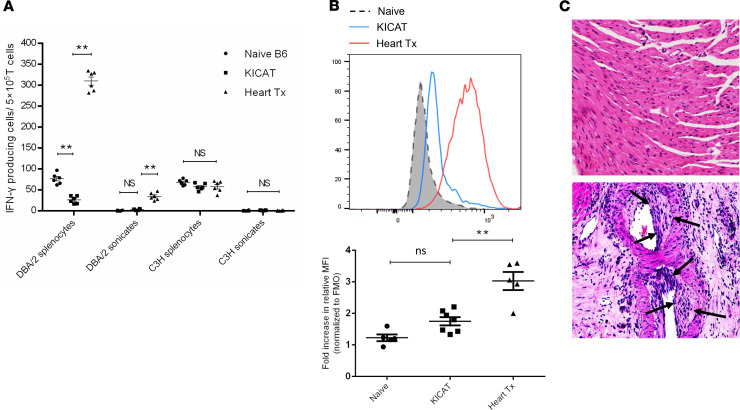
T cell alloresponse and development of CAV in long-term tolerant KICAT recipient mice.(A) ELISPOT assay analysis of different experimental groups (n = 6 in each group). T cells (responders) enriched from spleens of B6 recipients that received DBA/2 hearts with (KICAT group) or without DBA/2 kidneys (Heart Tx group) as well as from spleens of naive B6 mice were used. Responder cells were stimulated in vitro by syngeneic (B6), donor (DBA/2), or third-party (C3H) splenocytes (direct pathway) and the corresponding sonicates (indirect pathway). Values are shown as mean ± SEM; **P < 0.01, 1-way ANOVA. (B) Representative flow cytometric analysis for DSA toward DBA/2 in naive mice (shaded gray) and KICAT recipients (blue) (top). MFI fold change compared with FMO was quantitated (bottom) (n = 5 in control groups, n = 7 in the KICAT group) (bottom). Values are shown as mean ± SEM; NS, P = 0.2575 (naive vs. KICAT) and **P = 0.0012 (positive control vs. Heart Tx), 1-way ANOVA. (C) Representative images of DBA/2 heart allografts show myocardium with no signs of rejection (top) and CAV in an aortic branches (bottom) in long-term tolerant KICAT recipients. Mononuclear cells are seen within thickened intima (arrows), associated with reduction in luminal diameter. Scale bars: 200 μm.